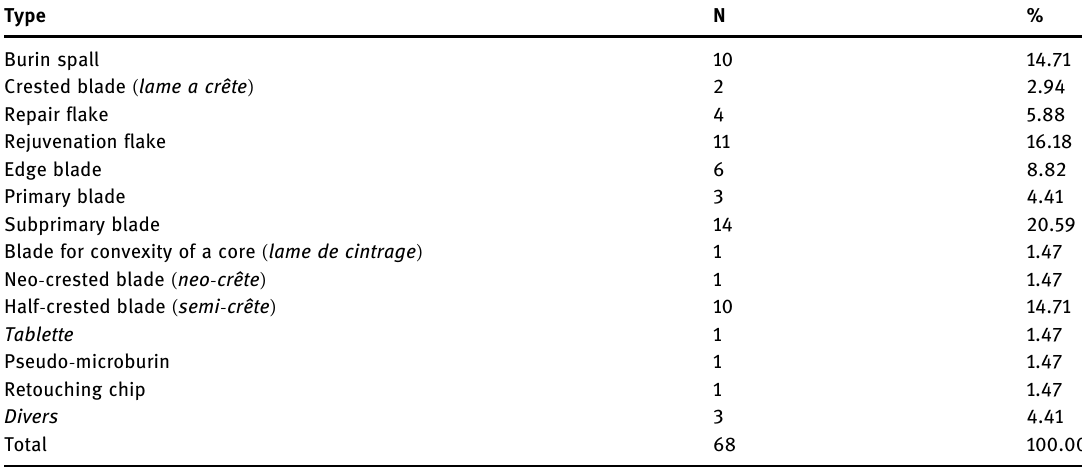
Table 5: Technological fl